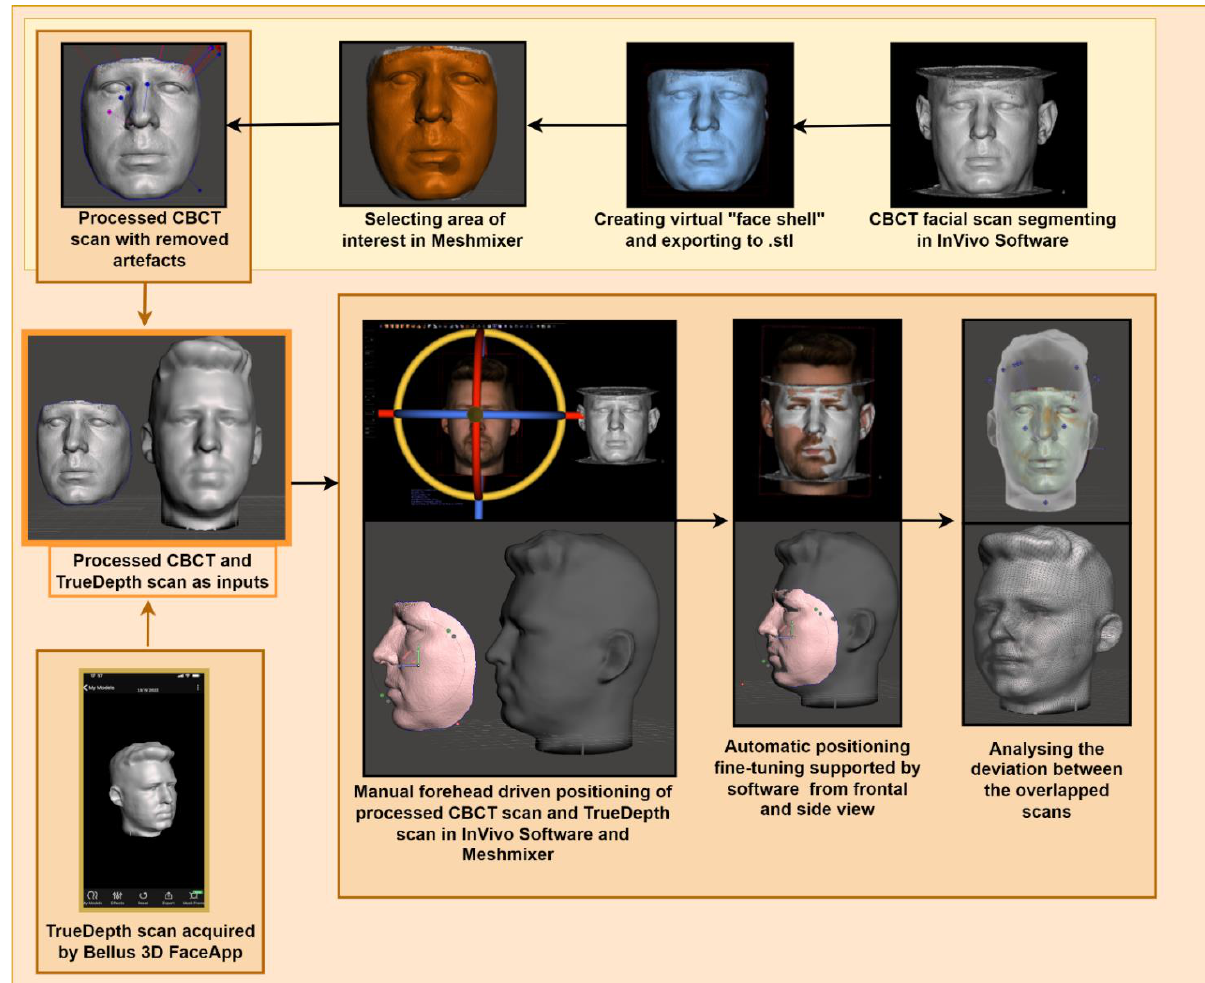
Figure 2. The schematic approach of the proposed method.